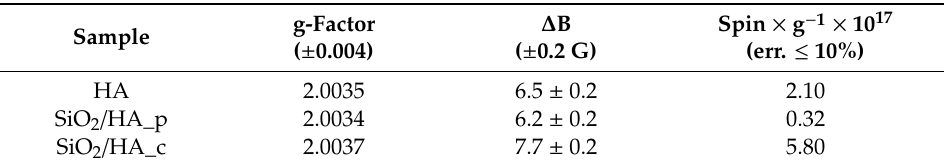
Table 3. Spectral parameters obtained by the EPR spectra of HA and SiO 2 / HA hybrid nanoparticles.